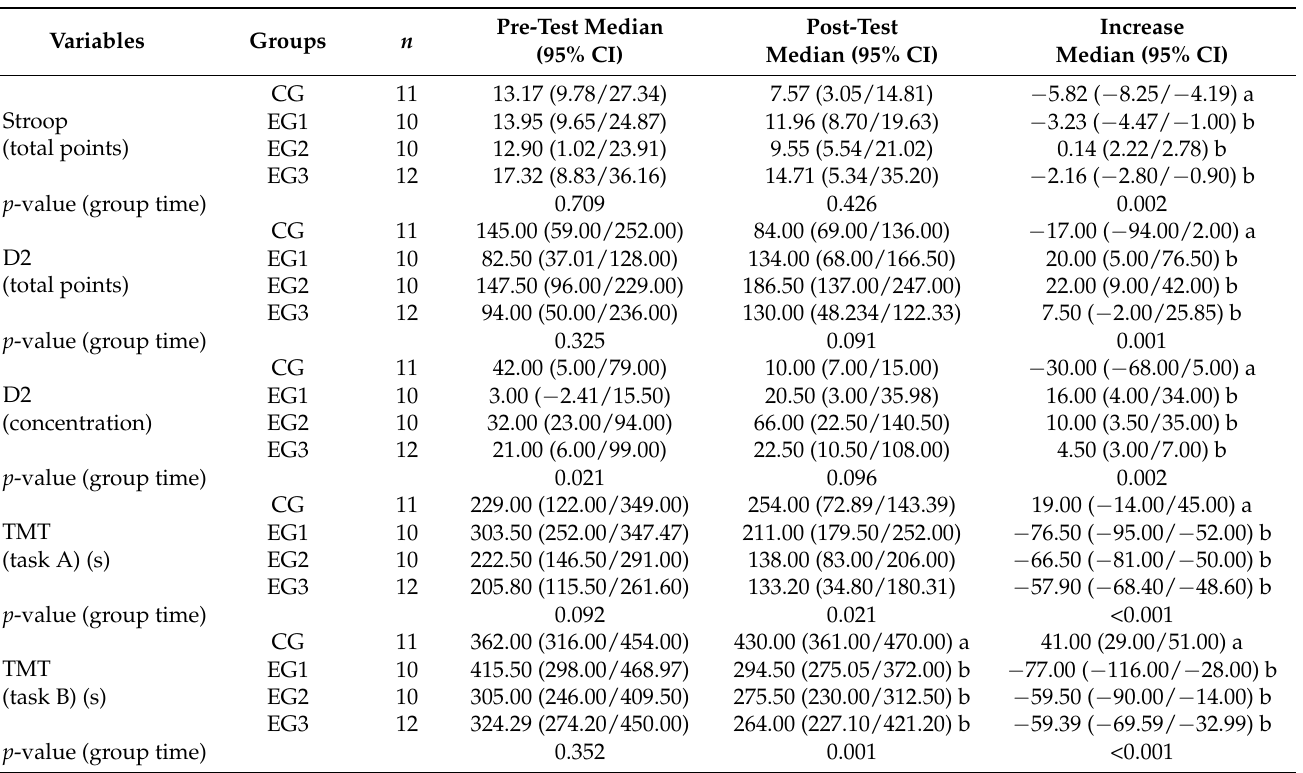
Table 2. Cognitive variables in pre- and post-test.